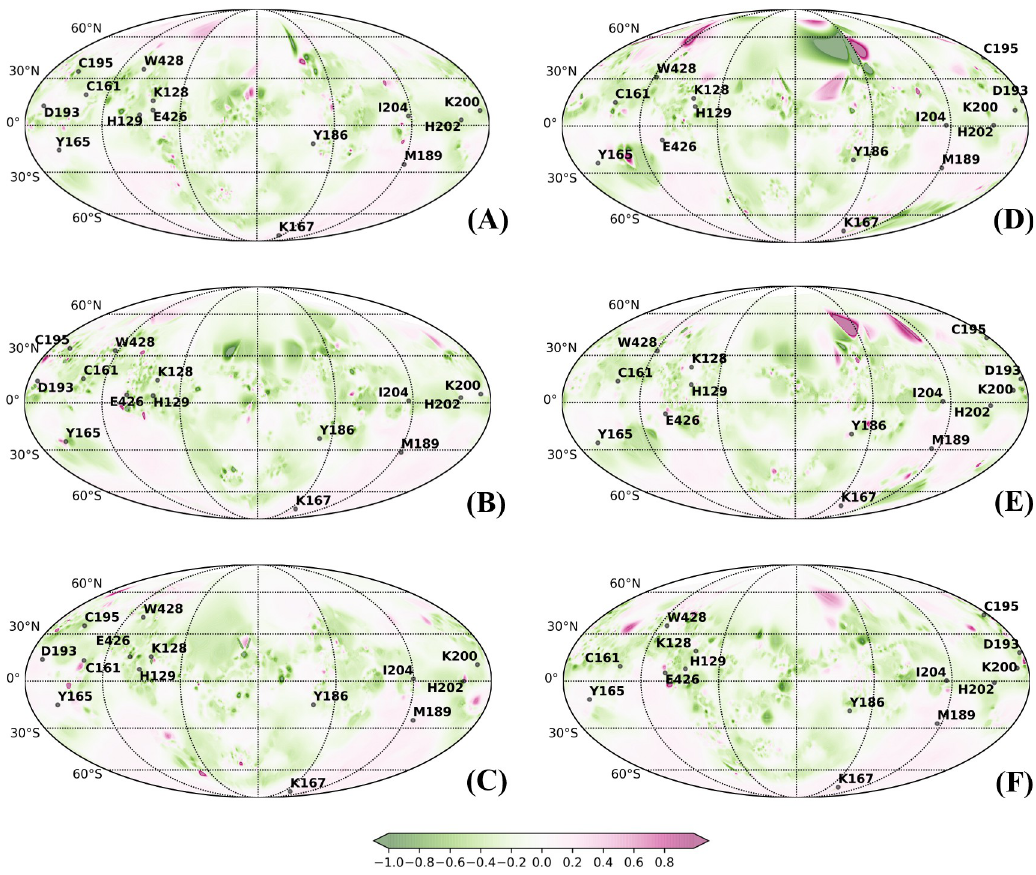
Fig 8. Protein surface topography representing molecular hydrophobic potentials (MHP) localized to the CRD region with fourteen key residues were mapped onto 2D spherical projections for visual comparison of free and bound forms of Calnexin in Canis lupus (CNXC): (A) Free_Clus1; (B) Free_Clus2; (C) Free_Clus3; (D) Complex_Clus1; (E) Complex_Clus2; and (F) Complex_Clus1.